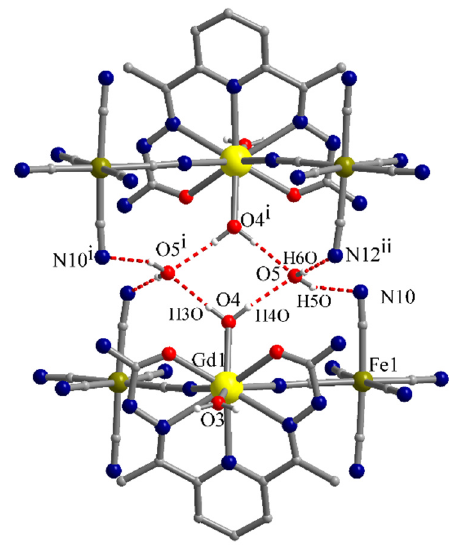
Figure 3. Detail of the packing diagram with the hydrogen interactions established between chains from neighboring supramolecular layers and crystallization water molecules in crystal 1 GdFe (sym- metry codes: i = 1 − x, − y, 1 − z; ii = 1.5 − x, − 0.5 + y,